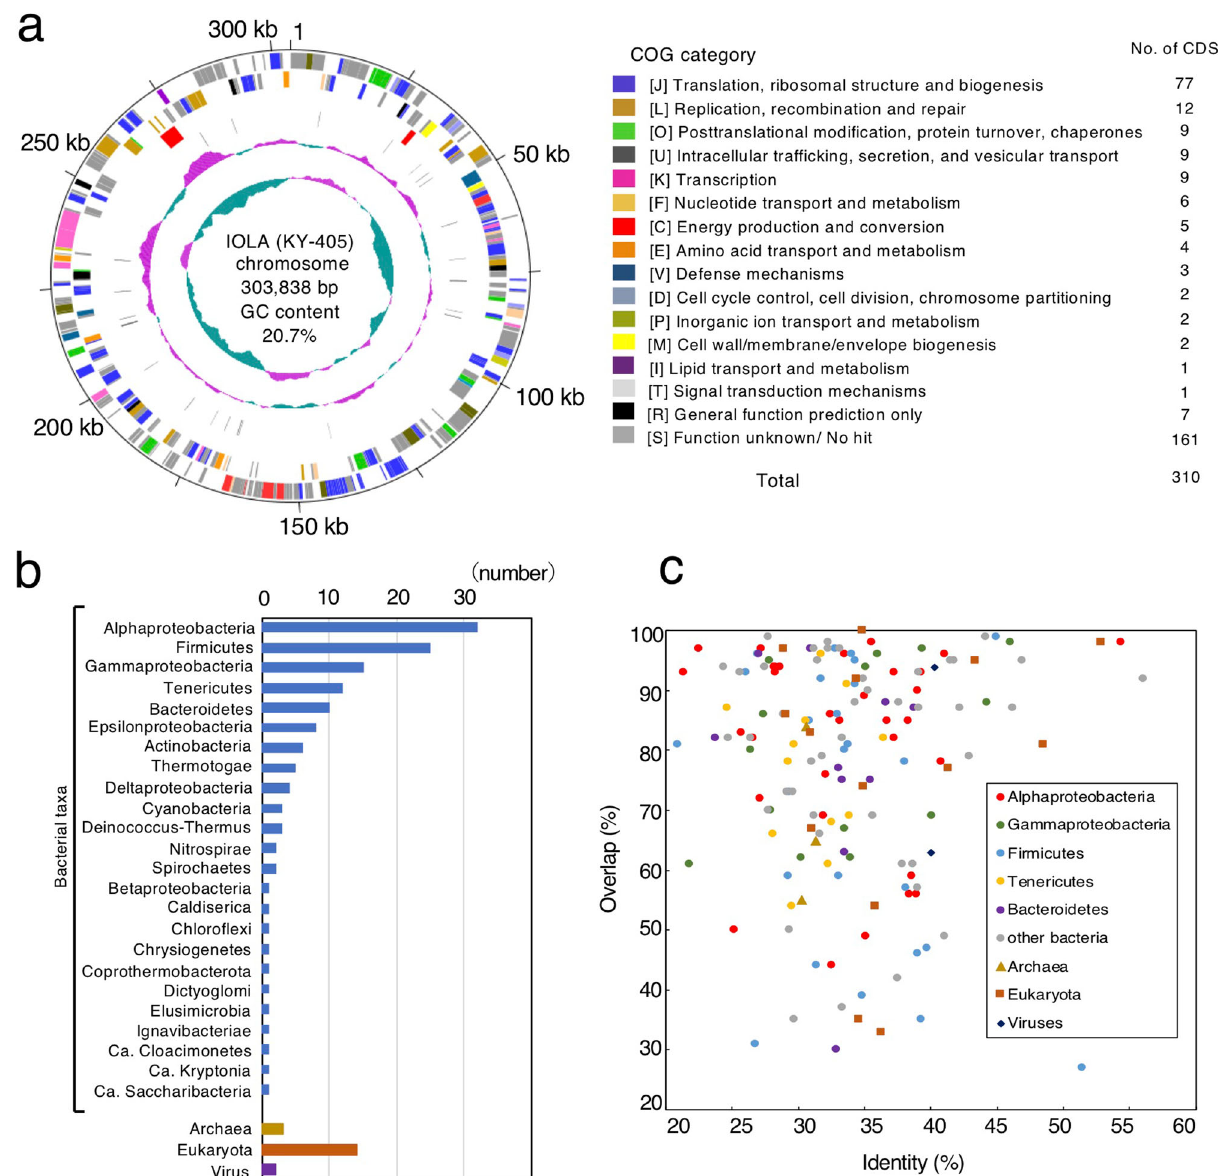
Fig. 2 CDSs in the IOLA genome and their homologies with known proteins. a Circular representation of the IOLA genome and COG classi fi cation of the CDSs. Circles from outside to inside: 1, scale in kb; 2, forward-strand CDSs; 3, reverse-strand CDSs; 4, rRNA genes; 5, tRNA genes; 6, GC content (graphic scale; upper: 0.3, center: 0.2, lower: 0.1); and 7, GC skew (graphic scale; upper: 0.25, center: 0.05, lower: − 0.15). The window size and the step size in circles 6 and 7 are 10,000bp and 1000 bp, respectively. b Taxonomic af fi liations of the top-hit proteins in the blastp search of each IOLA CDS. c Sequence identity (%) and overlap (%) of IOLA CDSs with the blastp top-hit proteins. Proteins from the top fi ve bacterial taxa, other bacteria (bacterial taxa with proportions less than 5%), archaea, eukaryotes, and viruses are indicated by different colors. Eleven of the 14 eukaryote top-hit CDSs had the top hits to the proteins of mitochondria and